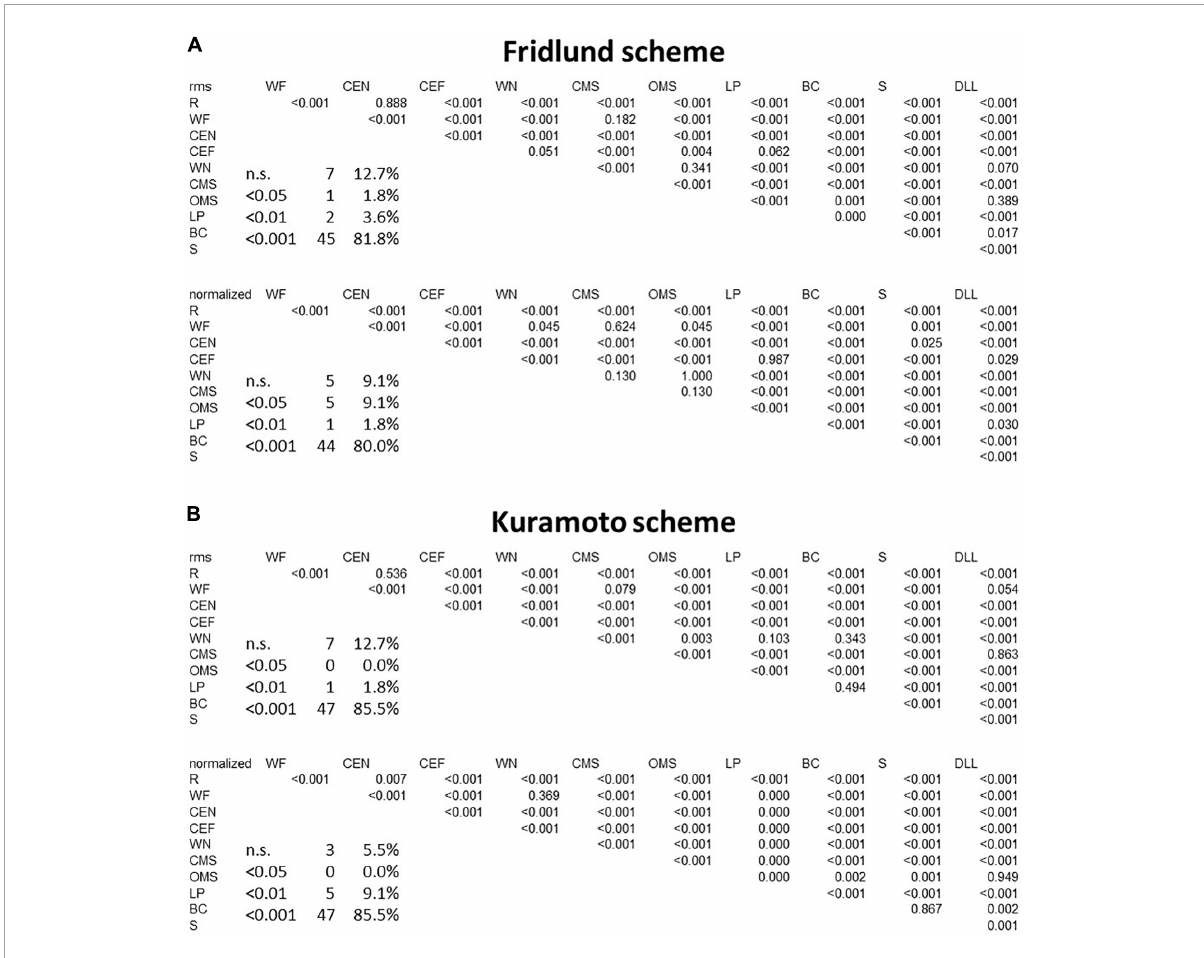
need the coordinated action of several facial muscles (cf. Figure 2 : not only muscles around the mouth are activated for smiling). Furthermore, the correct identification of all respective facial muscles requires highly trained personnel and is time-consuming to produce reliable results. Also, the post-processing (monopolar recording has to be converted into bipolar channels) bears some risks. For this reason, the Kuramoto scheme is of such interest. For this approach, called by the authors “myogenic potential topography,” the electrodes are placed on the face with fixed inter-electrode distance covering the entire face without reference to the underlying facial muscles. In the original study, the probands had to perform two mimic expressions (smiling and a disgusting face) different from the present study. Therefore, a comparison of the results is not possible. Using much more movement tasks, we were able to show that the Kuramoto scheme